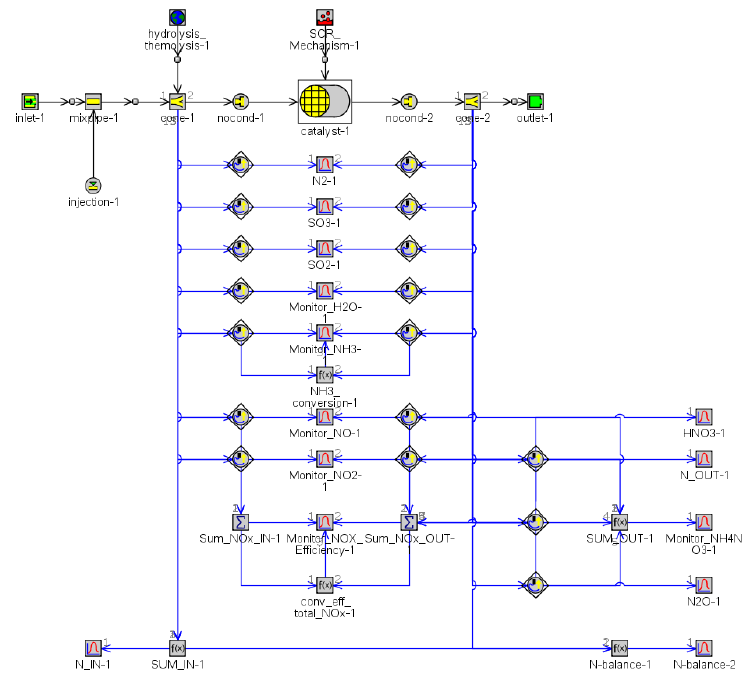
Figure 17. SCR system simulation model.